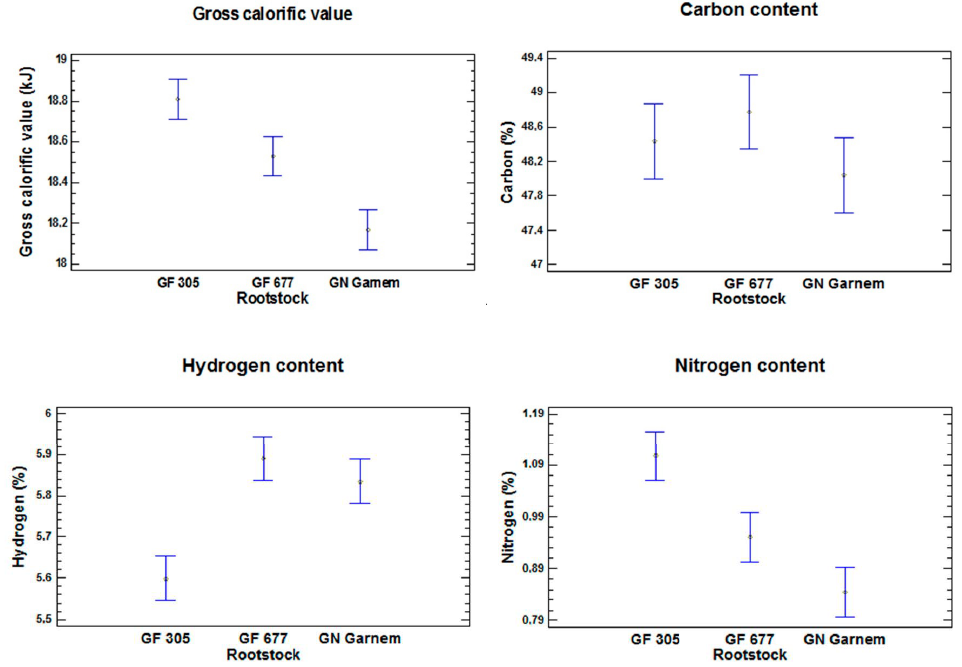
Figure 2. LSD intervals at 90% confidence level in the influence of the rootstock factor in residual biomass characteristics. ( n = 108).